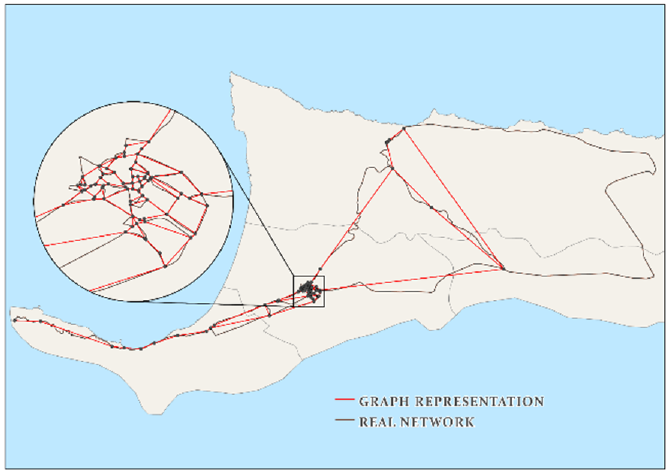
Figure 4. 2D graph representation of the study region’s real transportation network.